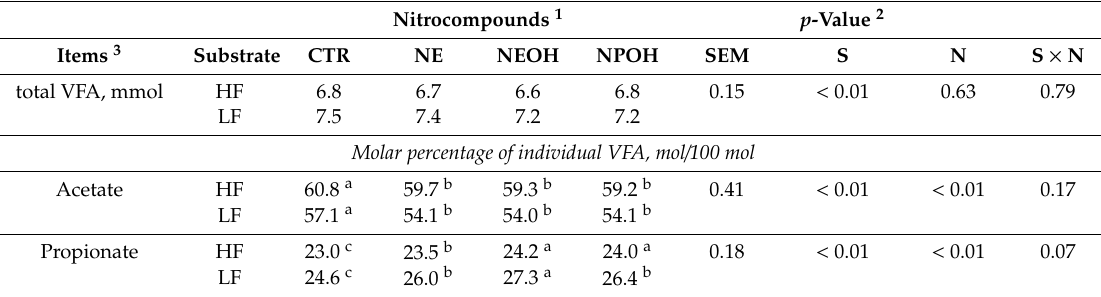
Table 1. E ff ect of 10 mM addition of nitroethane (NE), 2-nitroalcohol (NEOH), and 2-nitro-1-propanol (NPOH) in culture fluids on the production of volatile fatty acids (VFAs, mmol per incubations) and their pattern of substrates with a high (HF) and low (LF) forage content incubated in batch cultures of mixed rumen